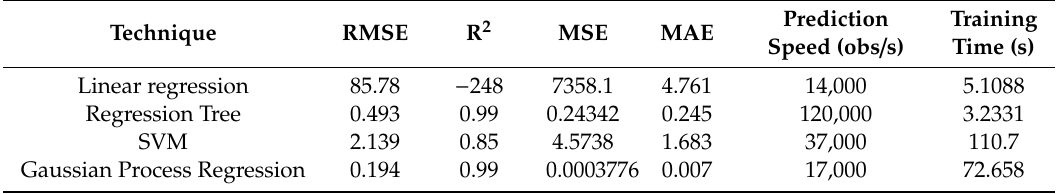
Table 3. Comparison of thermal stability validation results with other techniques.